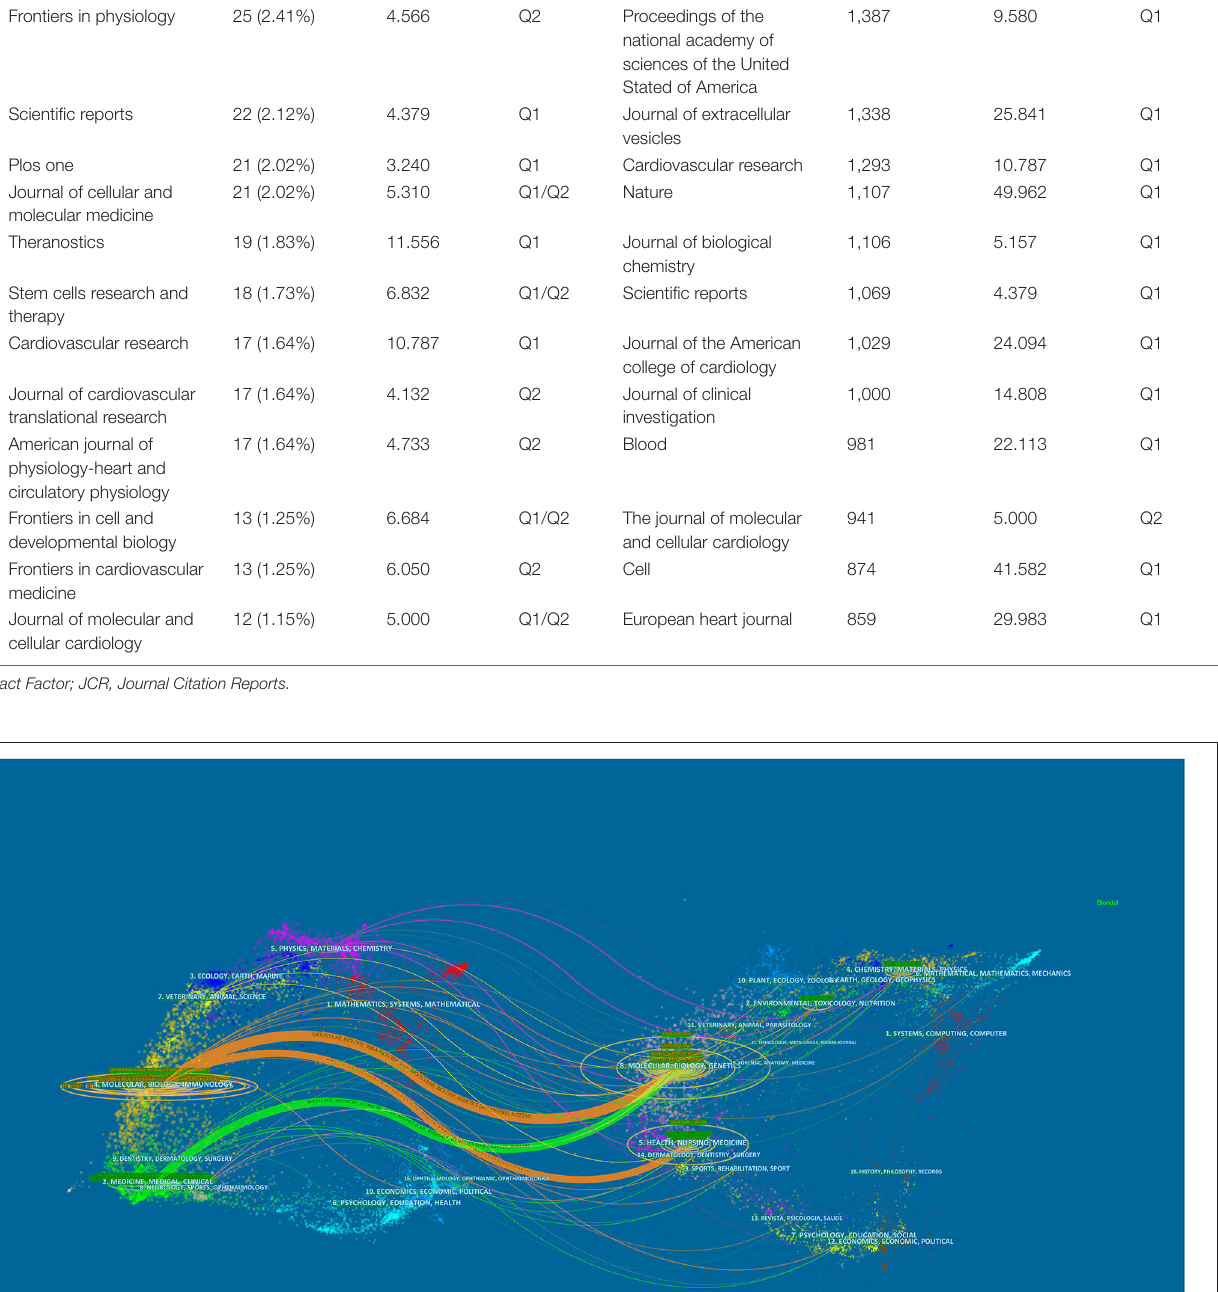
Frontiers in Cardiovascular Medicine |